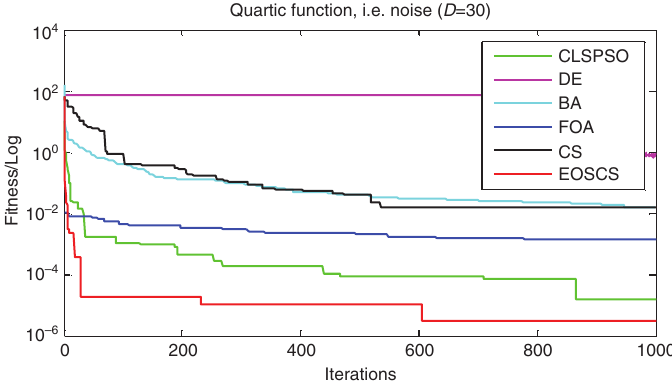
Figure 6: Convergence Curves for F